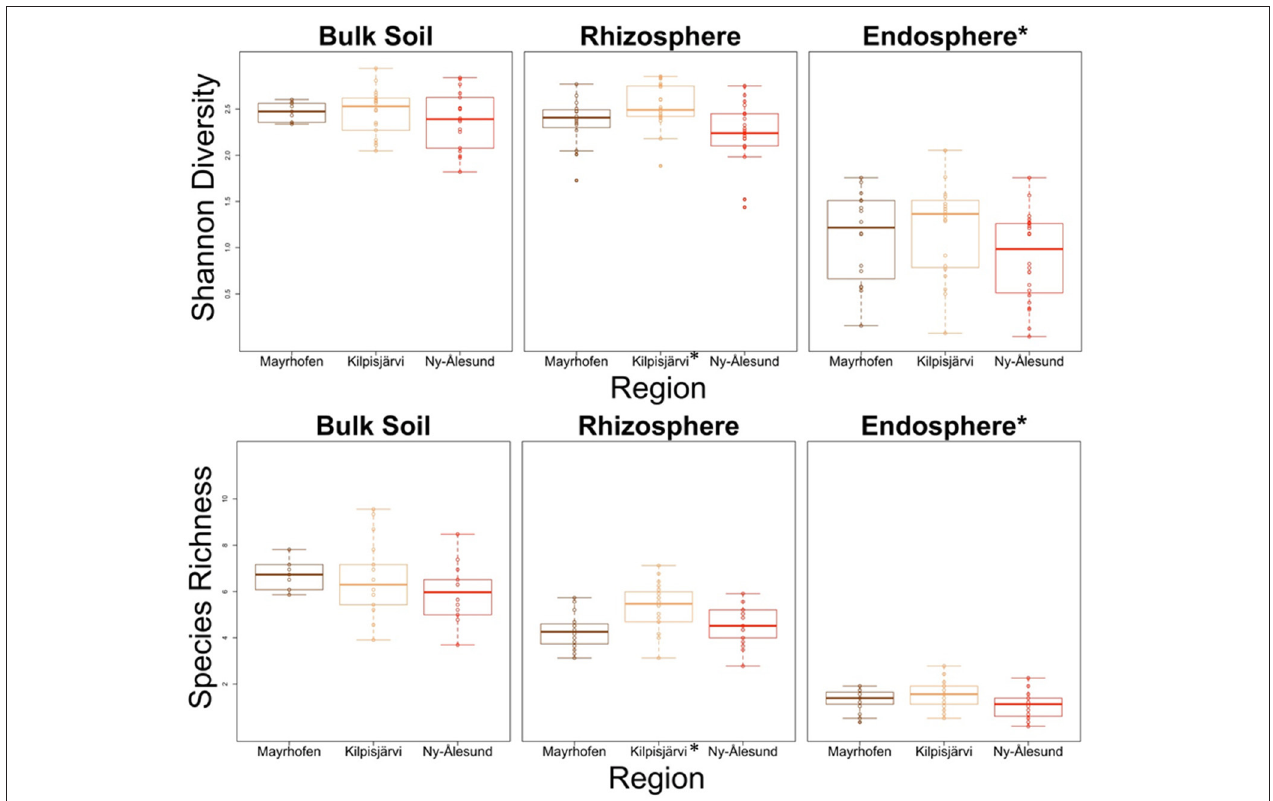
FIGURE 3 | Species richness and Shannon diversity of PNFB communities in different regions and compartments. Diversity indices were calculated using nifH gene OPUs as a proxy. Compartment or regions with differ significantly from other groups are marked by